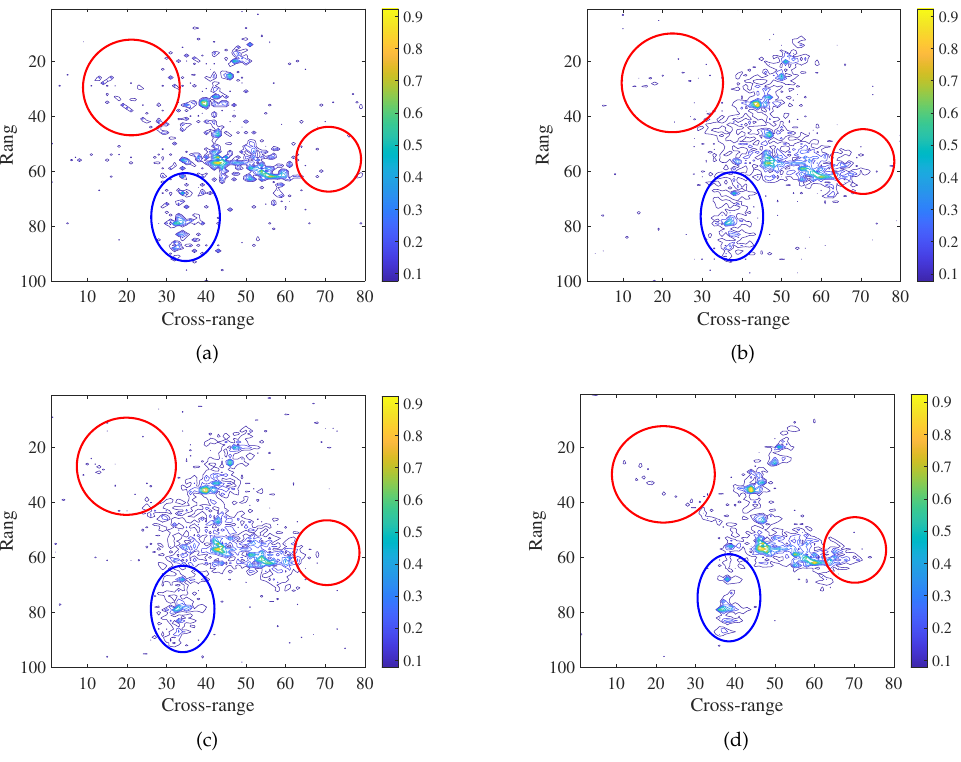
Figure 7. The imaging results of the plane data obtained by ( a ) GKF imaging method, ( b ) ONDL imag- ing method, ( c ) OFDL imaging method and ( d ) the GDL imaging method, using 25%